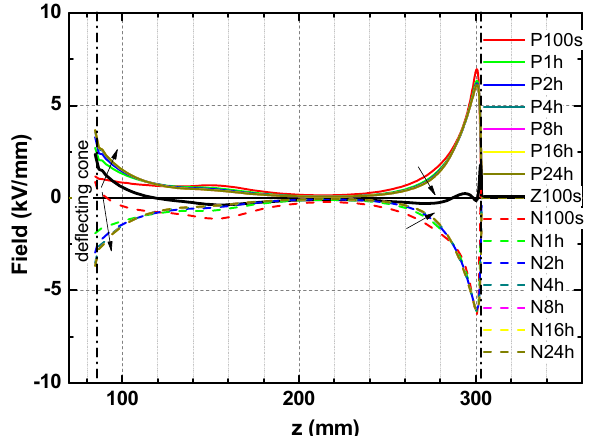
Figure 11. Tangential field distribution at XLPE/EPDM interface under isotherm condition at 70 °C.